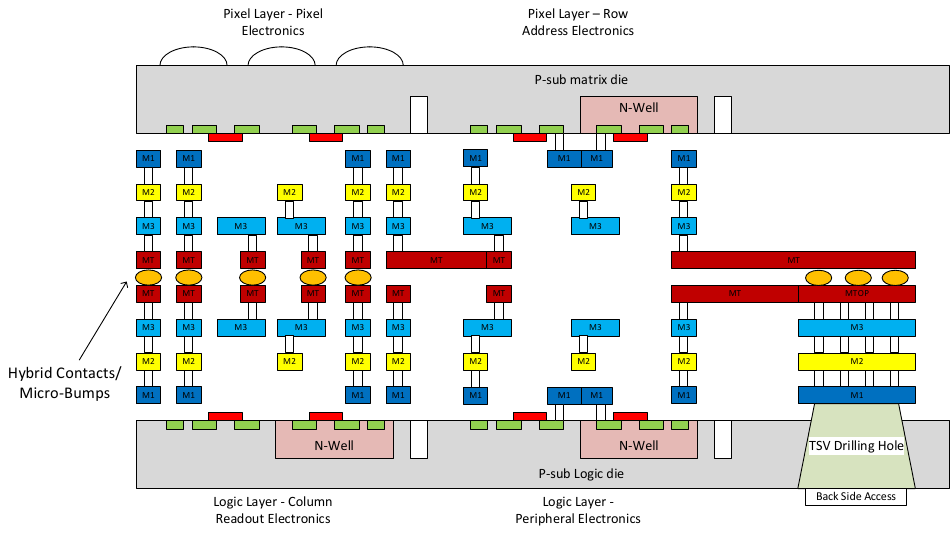
Figure 2. Example of two vertical silicon tiers metal stack interconnection for a 3D-stacked CIS. The top silicon tier drawn in Figure 2’s scheme is upside down (containing BSI pix- els—just for the current example—and usually contains the addressing circuit drivers) relative to the bottom silicon piece (containing all the readout electronics, including the